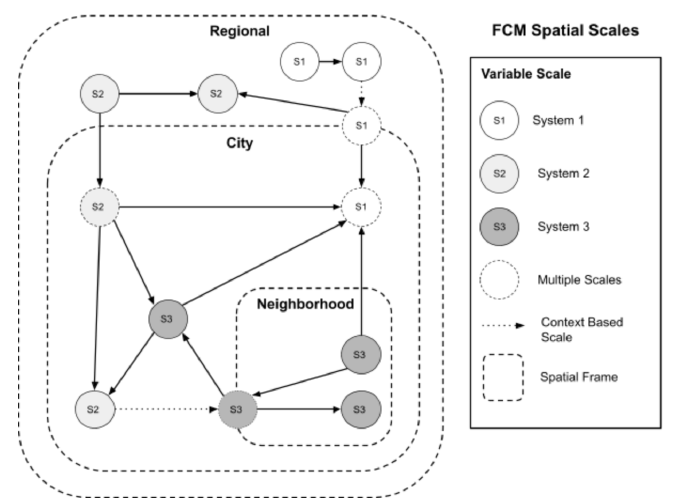
Figure 3. Fuzzy cognitive maps (FCM) have two distinct types of spatial scale: a spatial frame and system dynamic scales. The spatial frame represents the spatial scale in which the FCM was framed. The system dynamic scales are the contextual spatial scales of the variables and relationships that make up the FCM. Each variable has a spatial scale that depends on its relationships with other variables in the